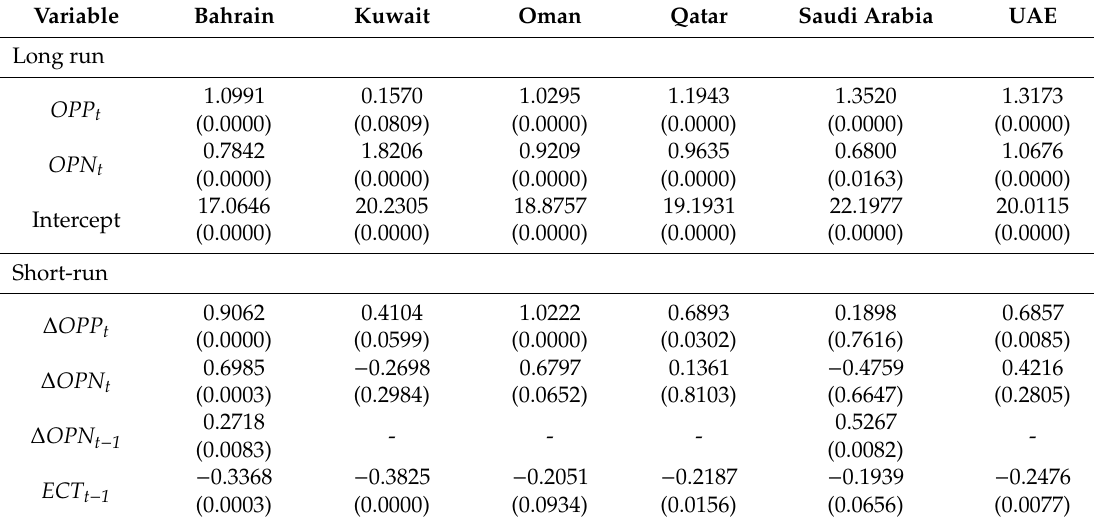
Table 3. Long- and short-run e ff